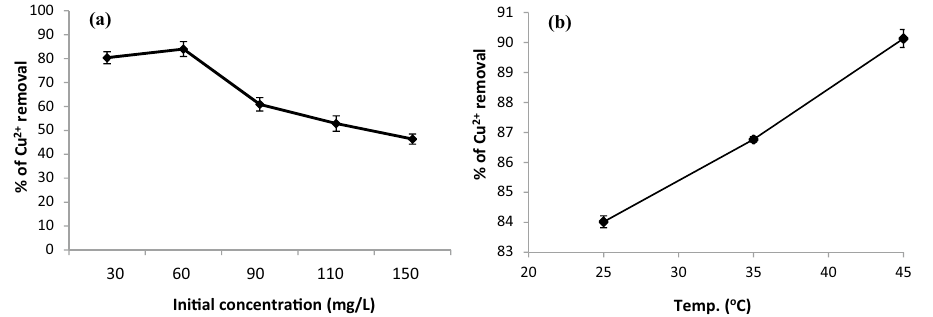
Figure 1. Effect of ( a ) Initial Cu 2+ concentration, and ( b ) Temperature on the biosorption of Cu 2+ ions onto R. damascena leaves. Data is presented as average ± SE of three